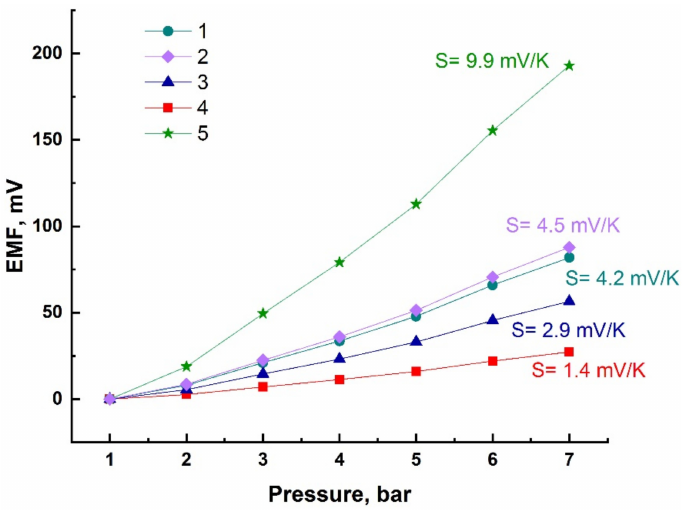
Figure 7. Dependence of the thermoelectrochemical cell EMF on the pressure at the vortex tube inlet, calculated on the basis of literature data: 1 – [29], 2 – [31], 3 – [32], 4 – [33], 5 – [34].